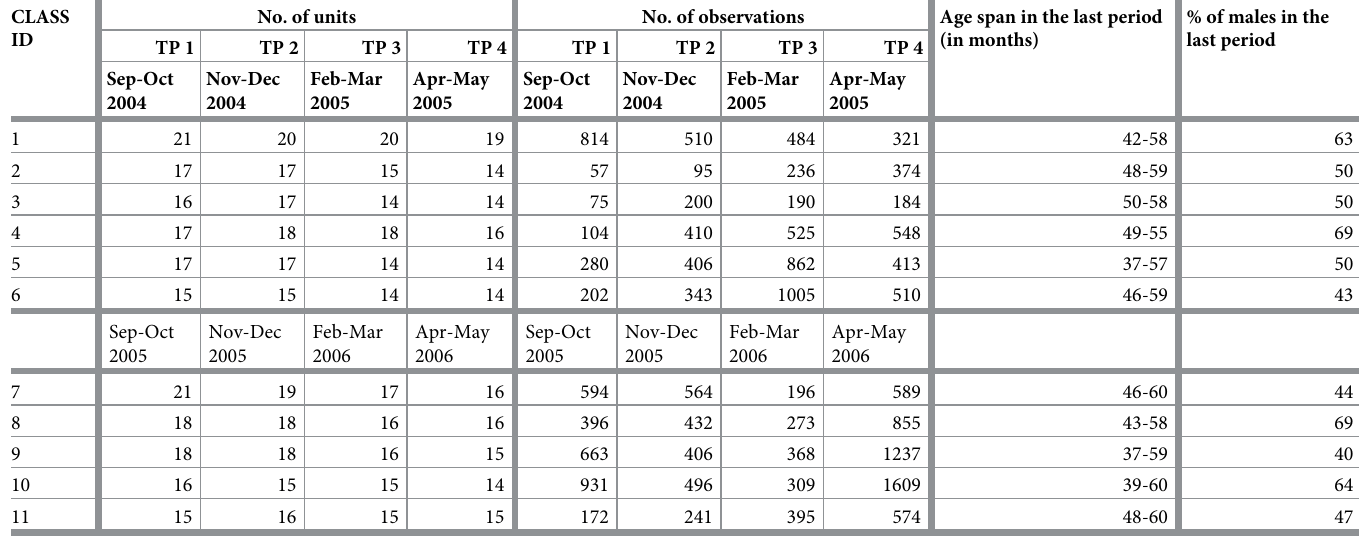
Table 1. Some basic descriptive statistics for the undirected networks. CLASS